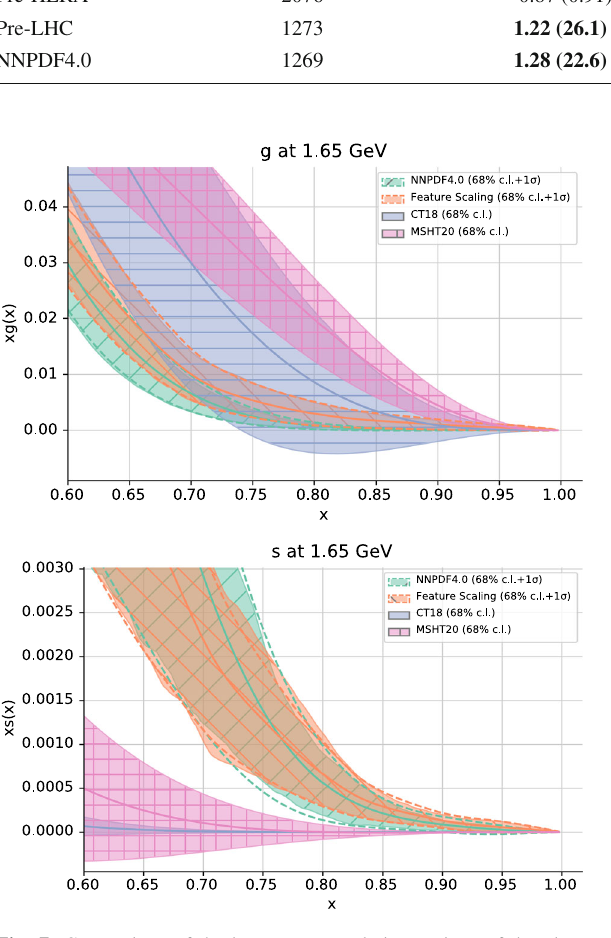
Fig. 7 Comparison of the large- x extrapolation regions of the gluon (top) and the strange (bottom) PDFs between NNPDF4.0 (green), fea- ture scaling (orange), CT18 [15] (blue), and MSHT20 [14]